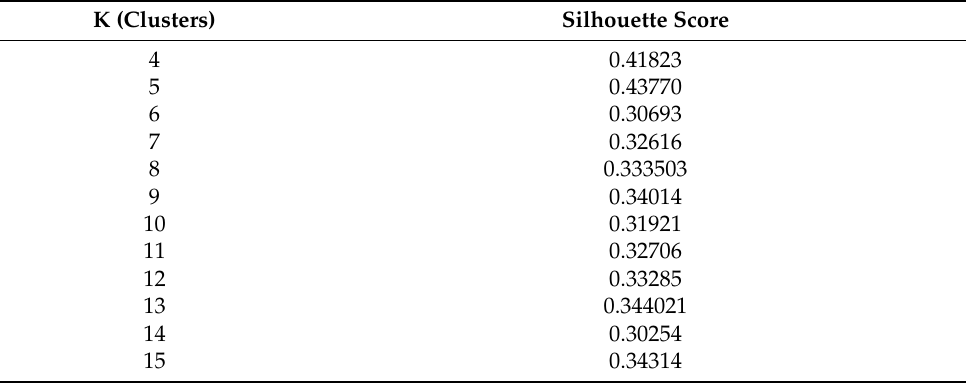
Table 6. Silhouette score for k (clusters).